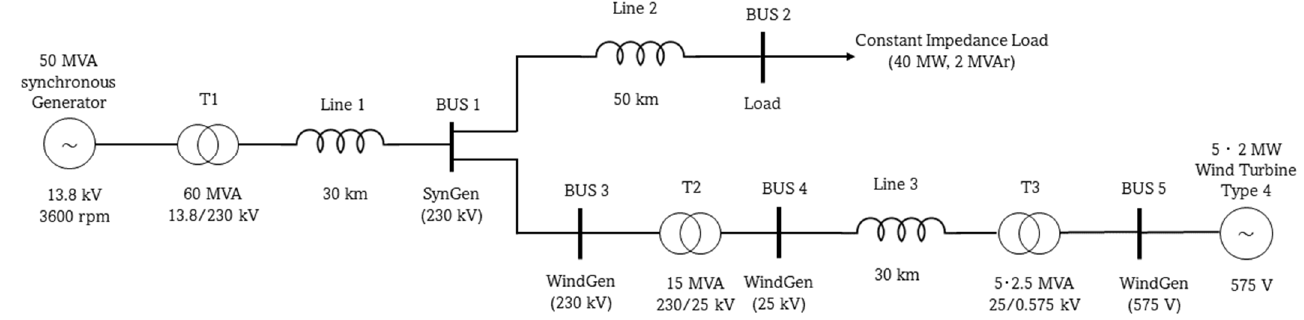
Figure 11. Power system test case used to compare the PLLs. Table 1. Time constants and reactance parameters of the synchronous machine used in the study. Parameter Symbol Value d -axis subtransient short-circuit time